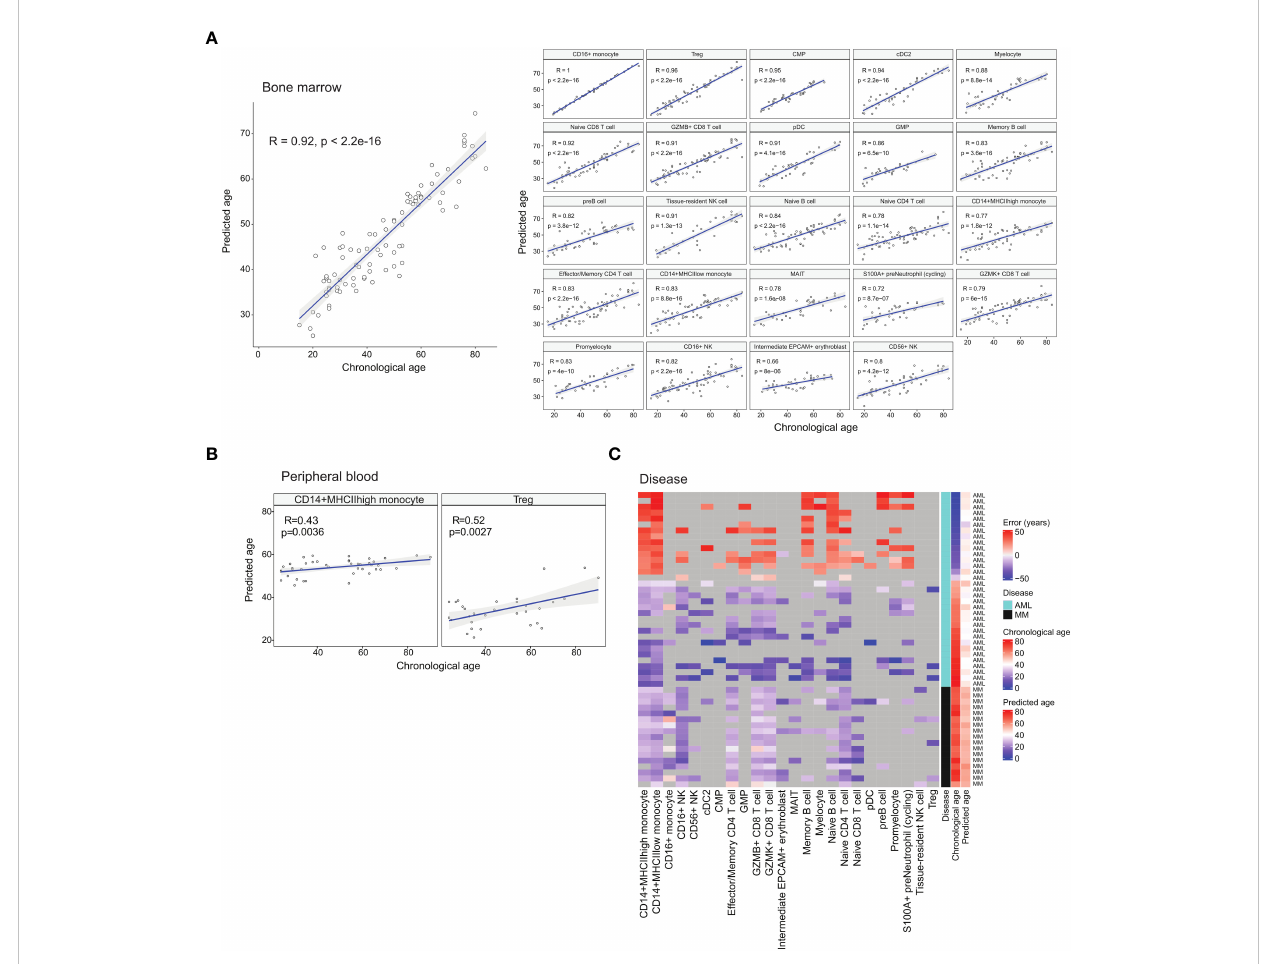
FIGURE 4 Age prediction using identi fi ed age-associated DEGs with machine learning. (A) Regression plots showing the correlation between chronological age and median predicted age of the respective cell types in healthy BM samples. (B) Regression plots showing the correlation between chronological age and median predicted age of select peripheral blood cell types. (C) Heatmap depicting the differences (error) between chronological age and predicted age of diseased BM